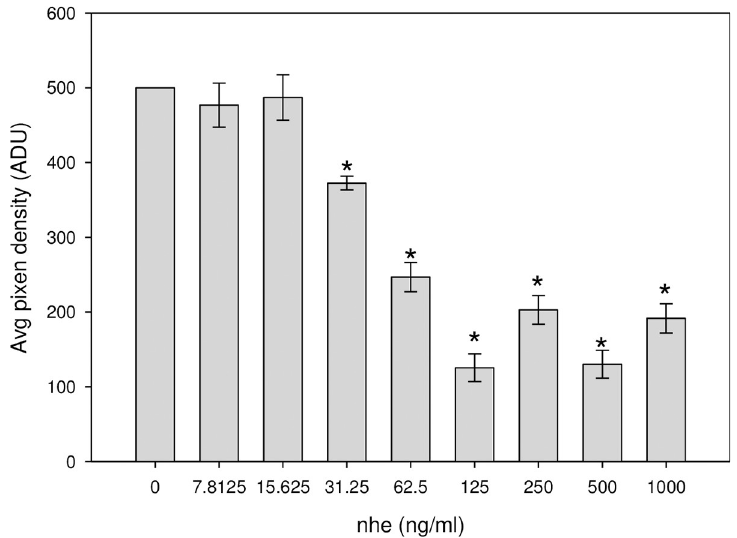
Fig 3. Biological activity of Nhe determined by measurement of the decrease in luciferase reaction generated light resulting from inhibition of protein synthesis. Transduced Vero cells with Ad-Luc were incubated with various concentrations of Nhe. Bioluminescence was detected using an SXVF-M7 CCD camera and expressed in average pixel density units. Values significantly different (P < 0.05) from control without Nhe are marked with an asterisk. Error bars represent standard